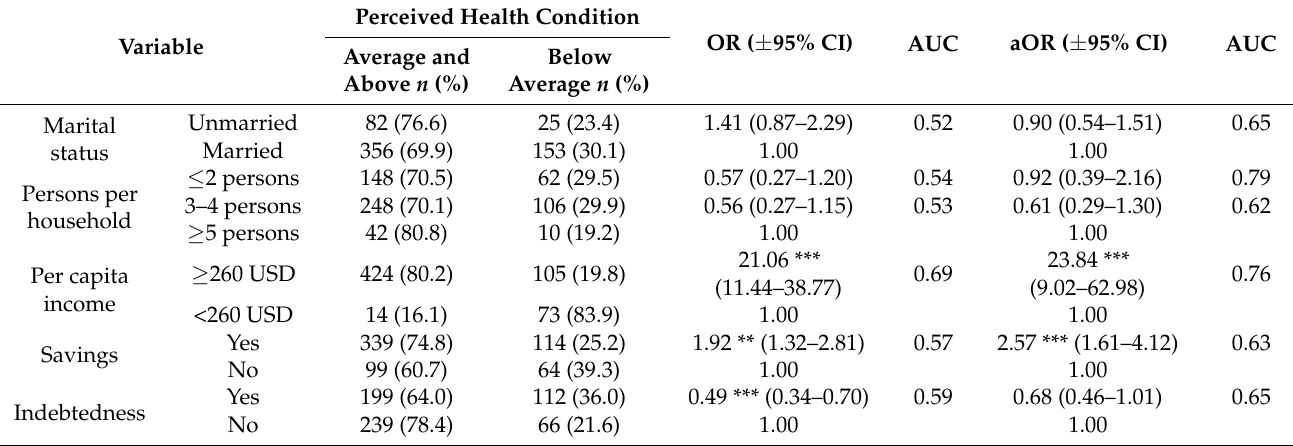
Table 4. Perceived health condition and socioeconomic status of private entrepreneurs from Wrocław ( N = 616).